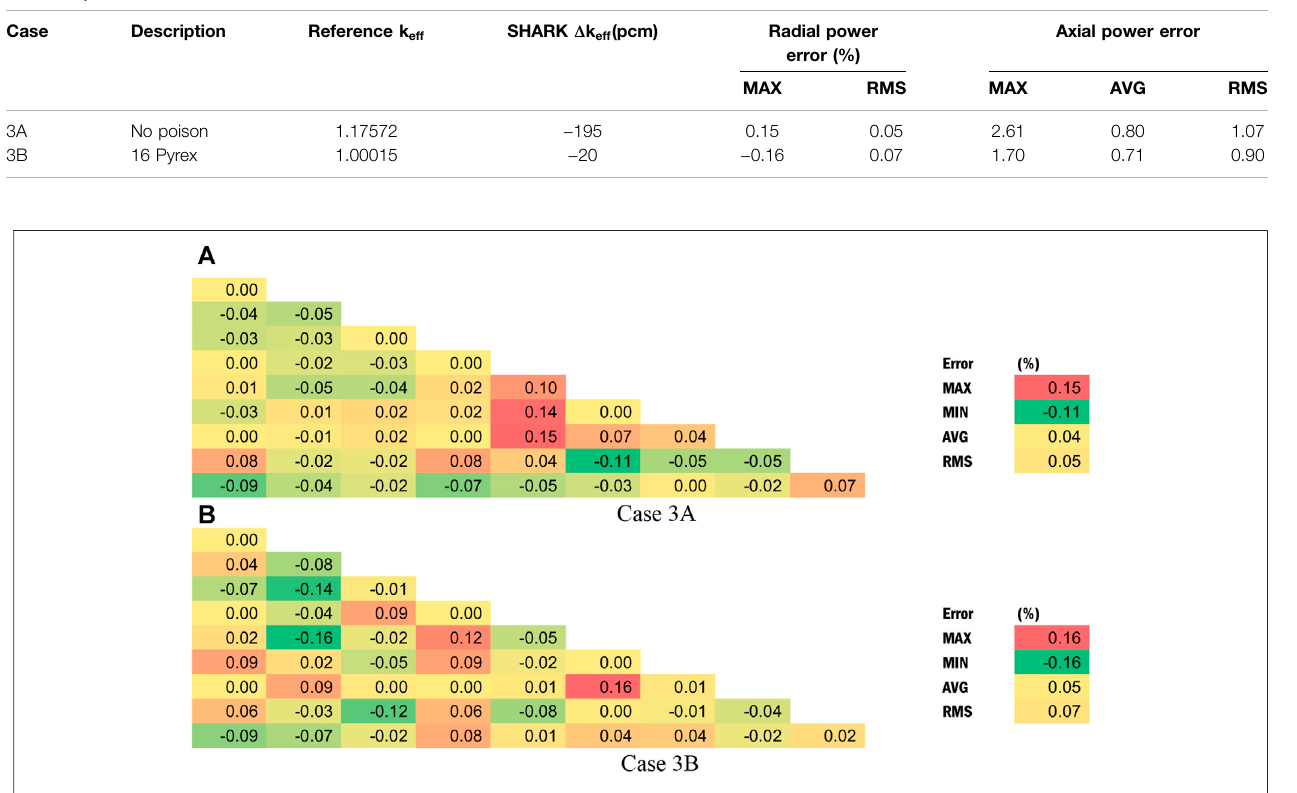
FIGURE 9 | Radial pin power error distribution of VERA-3